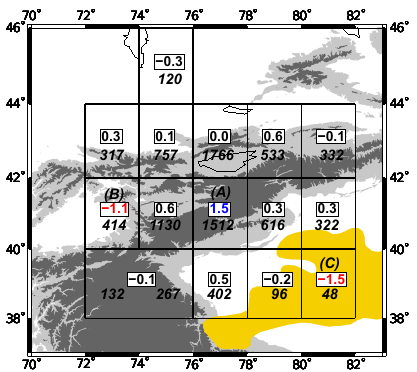
Figure 4. Residuals of the differential time between the P660s and P410s phases in seconds relative to the IASP91. Strongly anoma- lous boxes (A, B, C) are in south-central Tien Shan (1.5s, blue), Fergana Basin ( − 1 . 1s, red), and Tarim ( − 1 . 5s, red). Light shad- ing indicates elevations greater than 1500m, and intermediate shad- ing elevations greater than 3000m. The number of stacked receiver functions in each box is shown by italics. Permian basalts in Tarim are